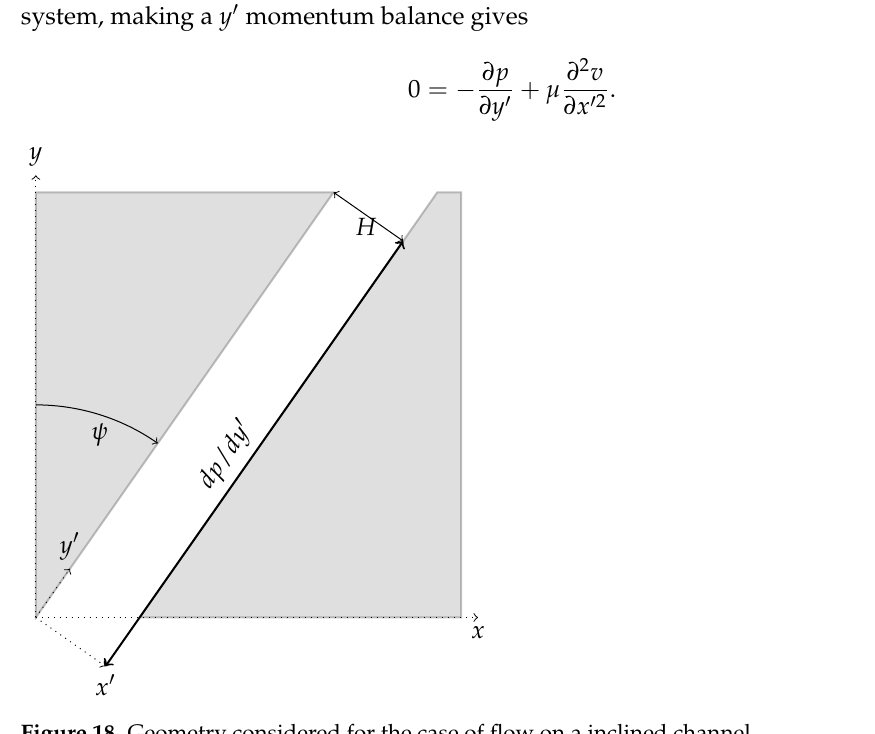
Figure 18. Geometry considered for the case of flow on a inclined